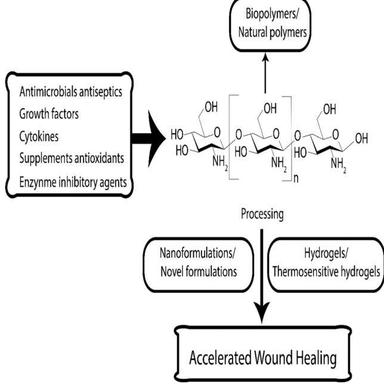
Role of biopolymers and biopolymer composites loaded with therapeutics such as Growth Factors, Cytokines, Antioxidants and Enzyme inhibitory agents that were processed as formulations and hydrogels in the process of accelerated wound healing.